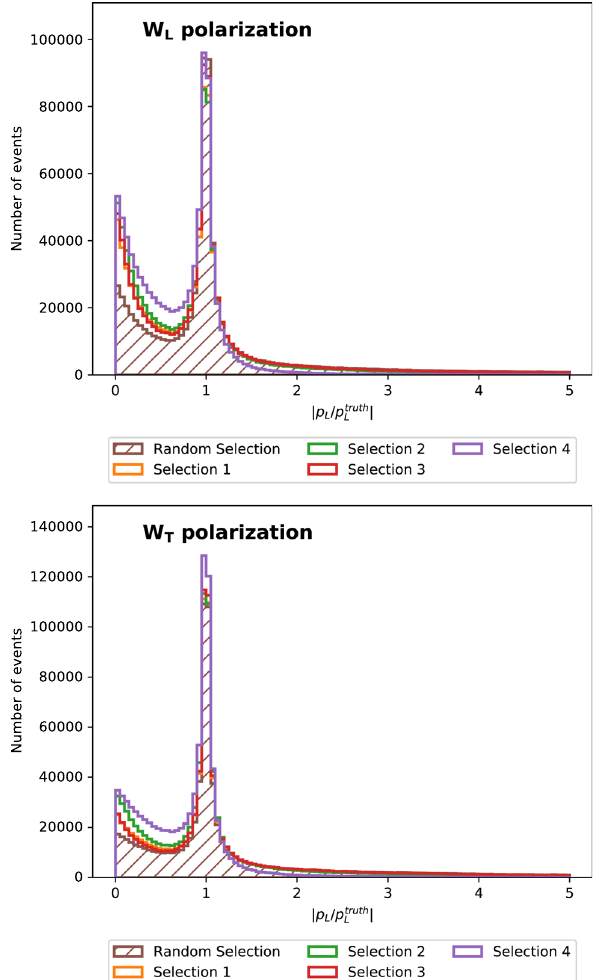
Fig. 2 Reconstruction of longitudinal neutrino momentum using dif- ferent selection criteria described in the text. The random selection is shown as the worst-case scenario. The ratio between the longitudinal neutrino momentum p ν L and the true (generator-level) value p truth ν shown. The top plot shows results obtained assuming the purely longi- tudinal (W L ) and the bottom plot the purely transverse (W T )